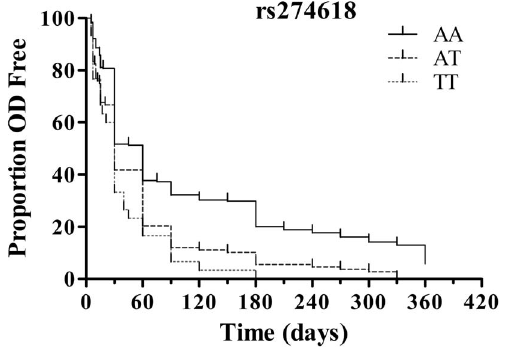
Figure 2. Kaplan–Meier survival curves representing probabil- ity that individuals have not experienced dependence over the period of time following first opioid use. Total addicts stratified by genotype of rs274618.